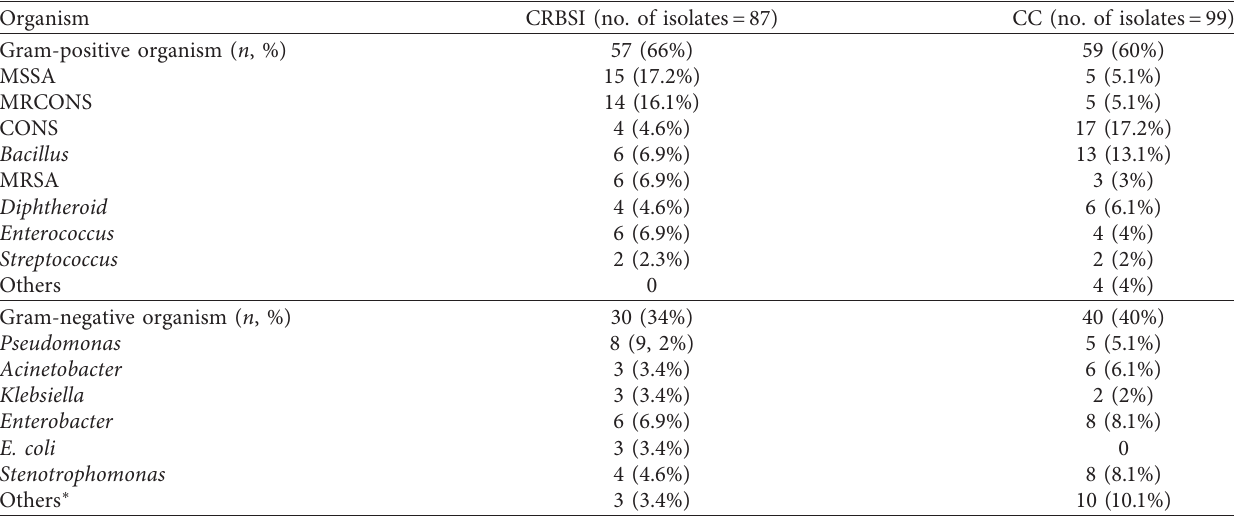
Table 6: Spectrum of cultured organisms in CRBSI and CC groups.